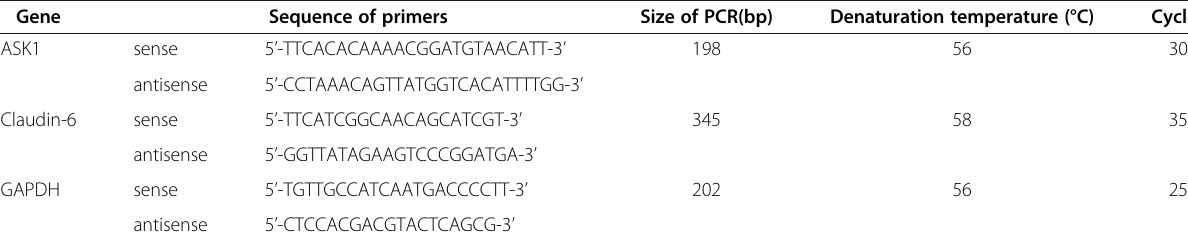
Table 2 Primers used for PCR Gene